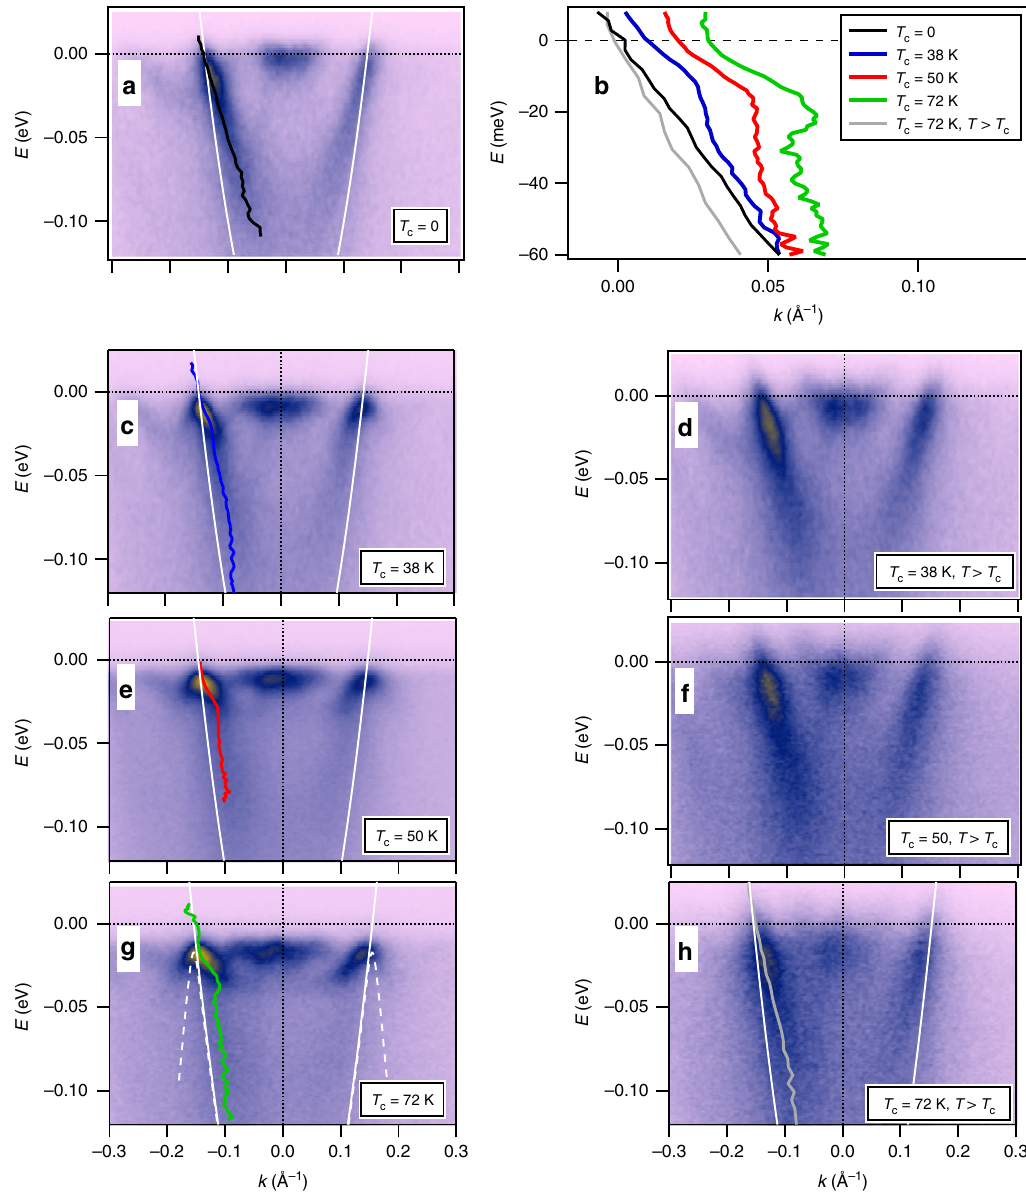
Fig. 2 Coupling strength in the overdoped Bi2212 as a function of doping. a Electronic structure of Bi2212 near the antinode along the momentum line indicated in Fig. 1b at low temperature ( T (cid:2) 10 K) for overdoped, non-superconducting sample. The spectra corresponding to the three overdoped ¼ 38 K, T ¼ 50 K, and T ¼ 72 K taken in the superconducting state ( c , e , g ) and normal state ( d , f , h ). The MDC- fi tted superconducting samples with T c c c dispersions of the bonding state are indicated by the black, blue, red, green, and gray curves. The TB dispersions are indicated by the solid white curves. The dashed white curve in g represents the TB dispersion gapped by Δ 0 ¼ 17 meV. b The same measured dispersions, referenced to the corresponding gap value. The momentum scale is referenced to k . The dispersions corresponding to superconducting states are offset in k by 0.01 Å (cid:3) 1 , consecutively. Spectra F in c , e , and g were recorded at T ¼ 12 K and those in d , f , and h at 45, 60, and 90 K,